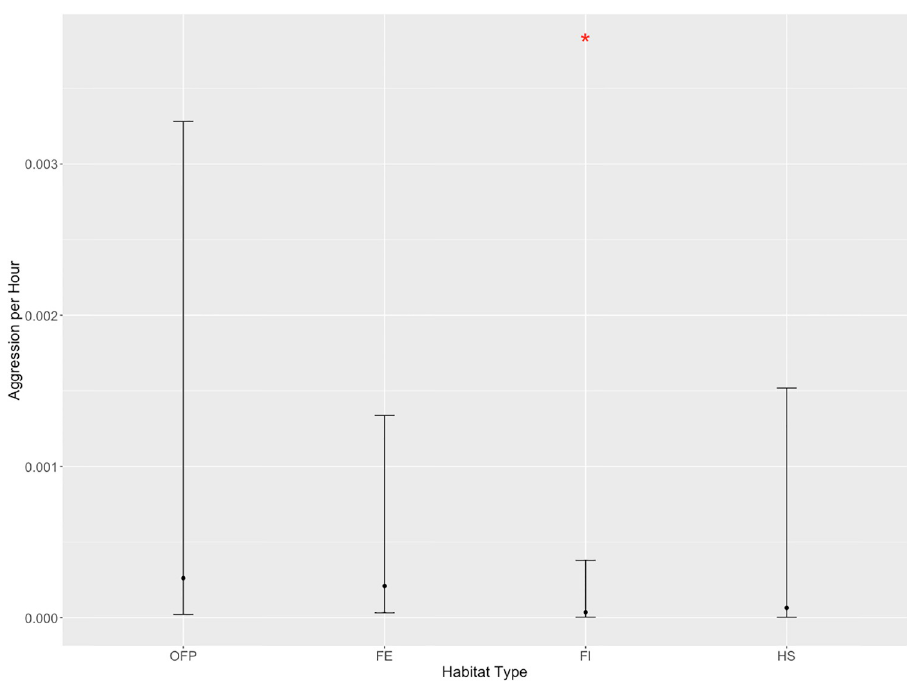
Fig 5. Predicted mean frequency of aggression per hour, across habitats types, with 95% confidence intervals. � Statistically significant at p � 0.05. FI = Forest Interior, FE = Forest Edge, OFP = Open Forest Patch, HS = Human